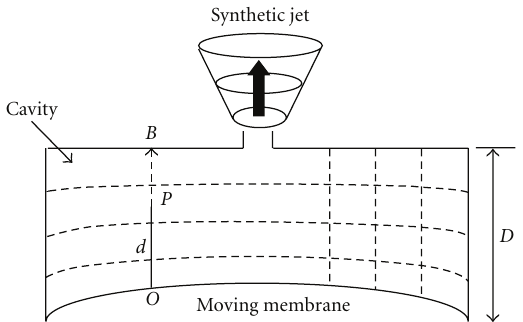
Figure 1: A typical geometric representation of the synthetic jet